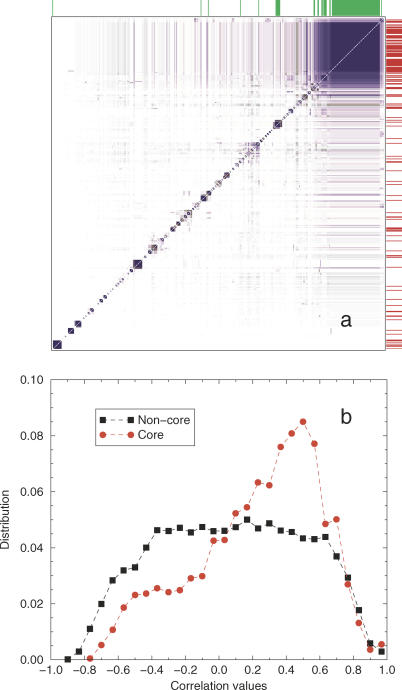
Correlations among E. coli Metabolic Reactions(A) We calculated the Pearson correlation using flux values from 30,000 conditions for each reaction pair before grouping the reactions according to a hierarchical average-linkage clustering algorithm. The values of the flux-correlation matrix range from −1 (red) through 0 (white) to unity (blue). The horizontal color bar denotes if a reaction is a member of the core (green), and the vertical color bar denotes whether the enzymes catalyzing the reaction are essential (red).(B) Distribution of Pearson correlation in mRNA copy numbers from 41 experiments [14]. The correlations of the core reactions are clearly shifted towards higher values, with an average correlation coefficient of <C> = 0.23 compared with the average noncore coefficient of <C> = 0.07